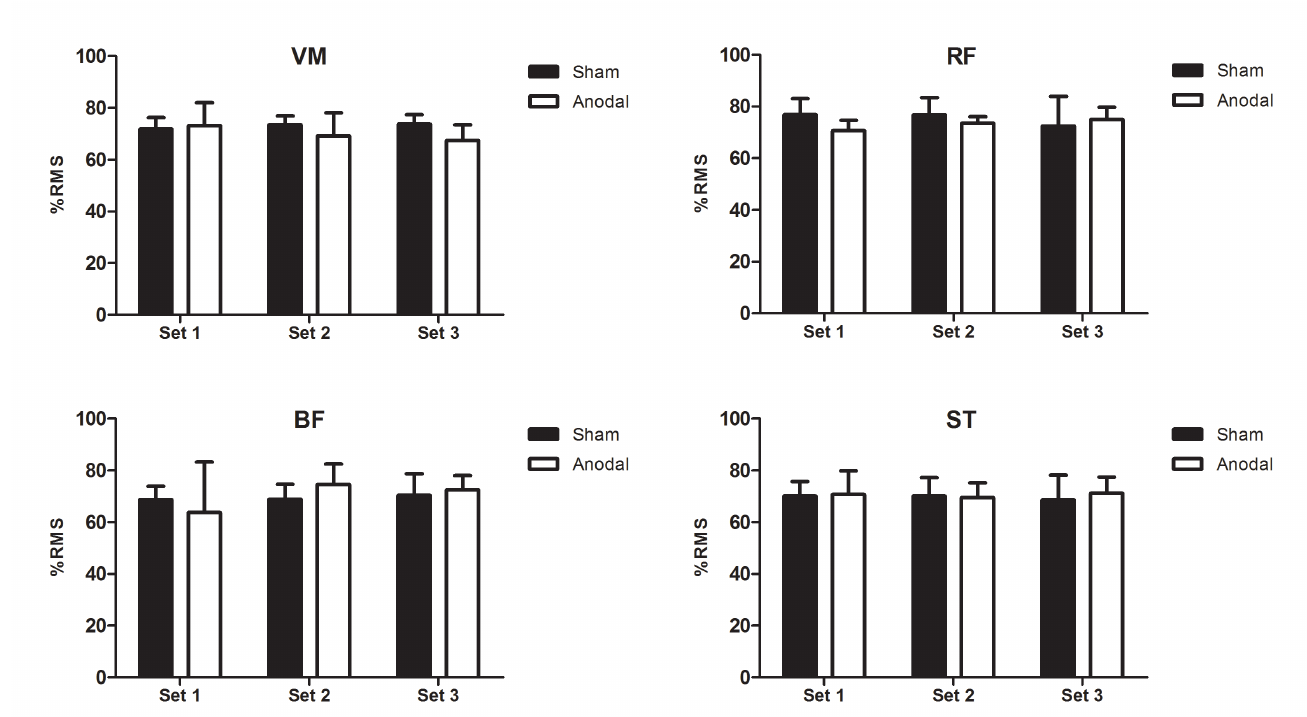
Figure 4. Mean±SD values of %RMS obtained by surface electromyography assessment for the vastus medialis (VM), rectus femoris (RF), biceps femoris (BF) and semitendinosus (ST) within maximal isokinetic strength exercise after sham and anodal tDCS ( n =6). 2-way ANOVA with repeated measures did not detected significant differences between anodal and sham tDCS for %RMS ( P = .64). %RMS = root means square percentage. tDCS = Transcranial direct current